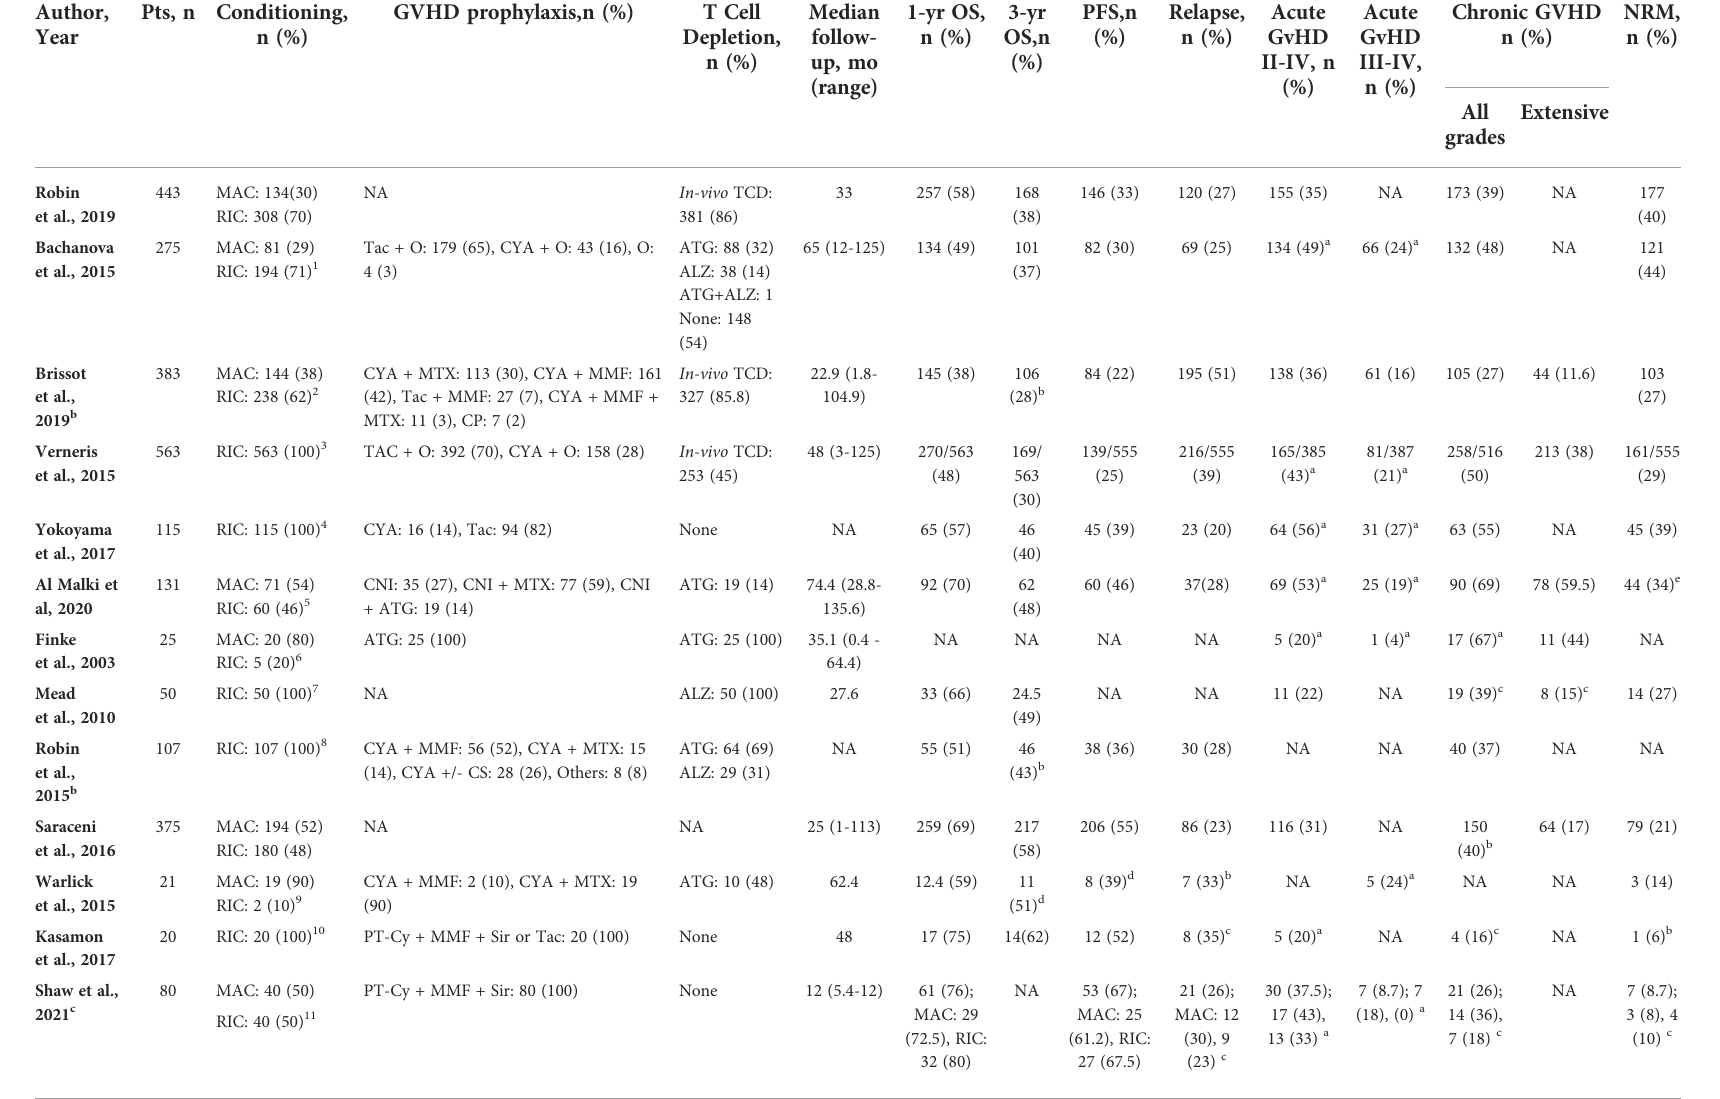
TABLE 2 Outcomes of mismatched unrelated donor allogeneic stem cell